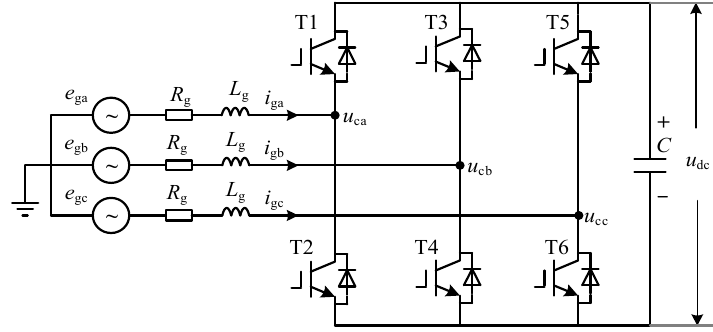
Figure 2. Schematic of three-phase VSC for each converter station.